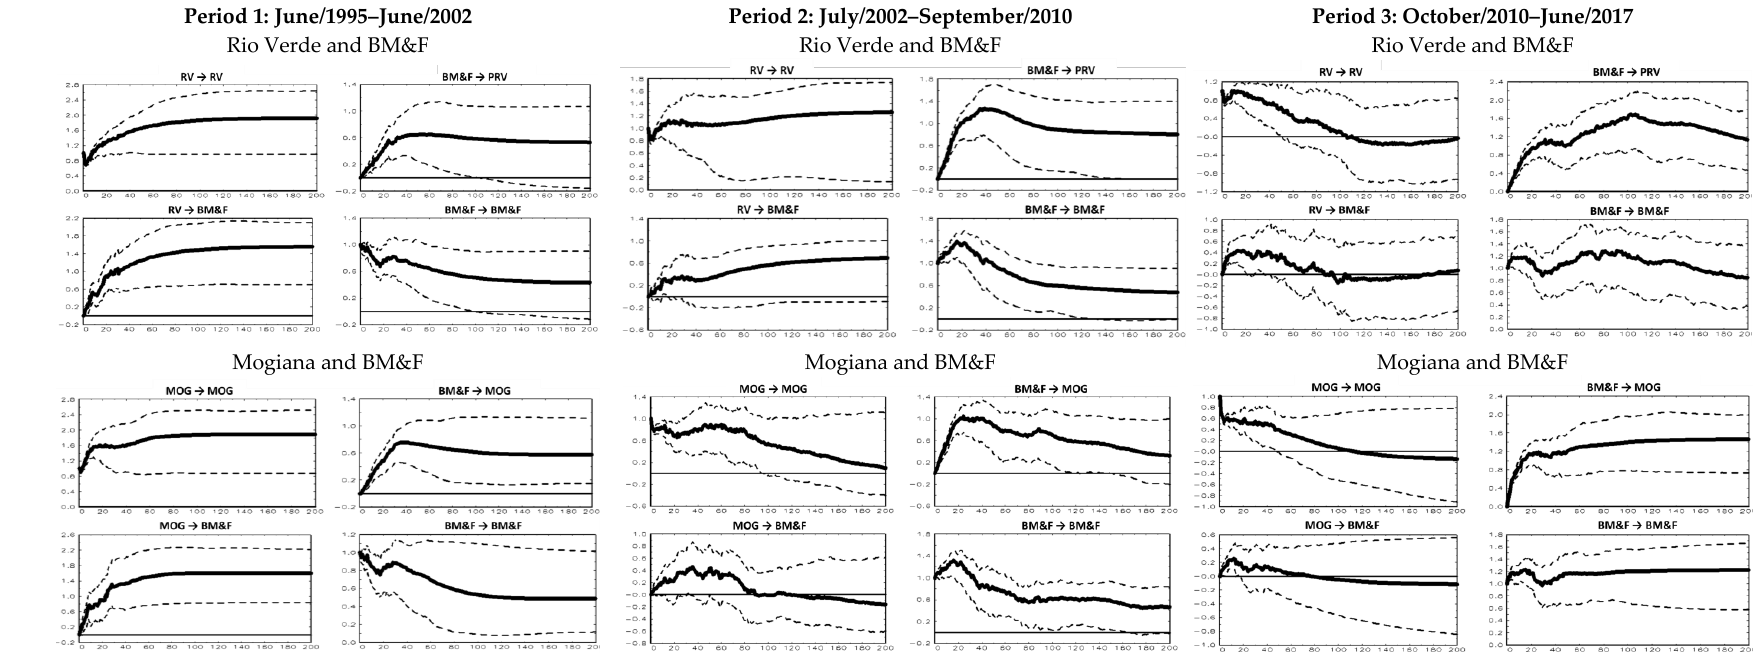
Figure A2. Impulse-response analysis for spot and futures prices in Brazil. Note: the 95% bootstrapped confidence intervals are based on Benkwitz et al. (2001).